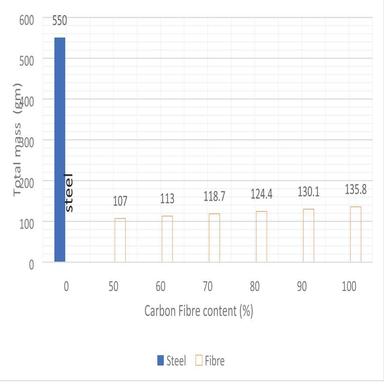
Total mass of steel and composite drive shaft.